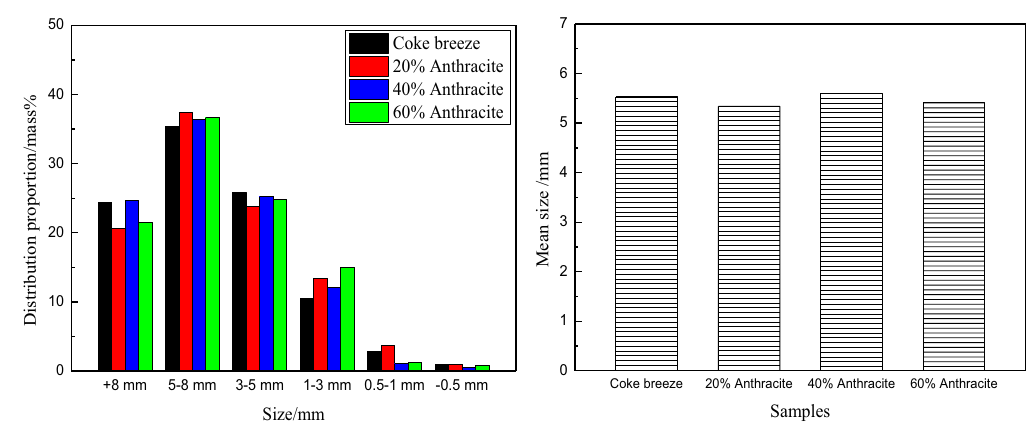
Figure 5. Effect of substituting anthracite for coke breeze on granule size